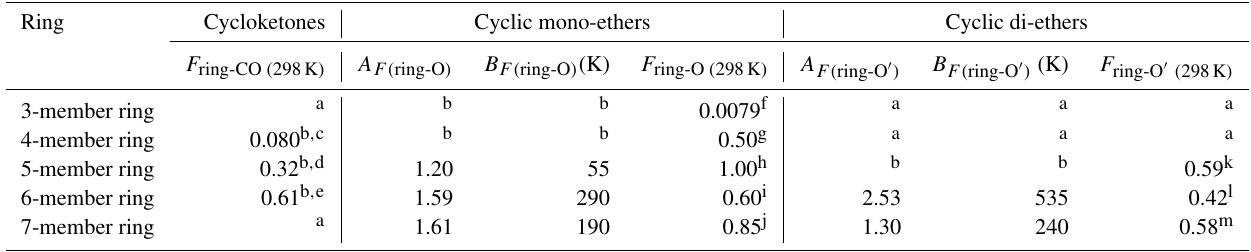
Table 6. Ring factors, F ring , for the reactions of OH with cyclic oxygenates, and their temperature dependences described by F ring = A F( ring ) exp ( − B F( ring ) /T